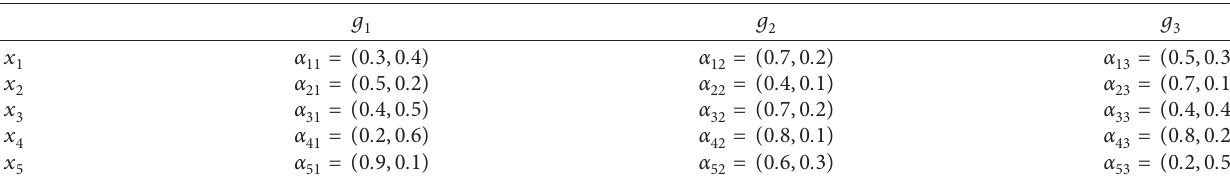
Table 1: Decision matrix.